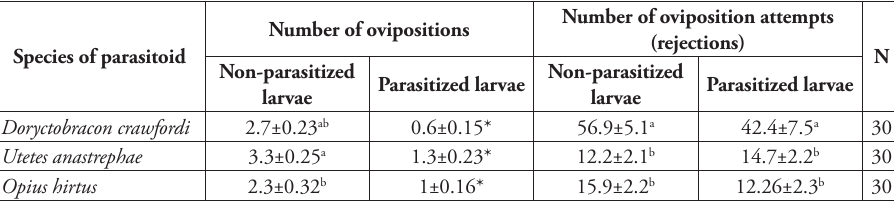
Different letters indicate statistically significant differences (Anova, α =0.05) between species of parasitoids. *Indicates a statistically significant difference between parasitized and non-parasitized hosts. Table 3. Average values (±SE) of duration of oviposition, vibration of the abdomen of the females, and im- mobility of the host after stinging (all in minutes) in non-parasitized and parasitized host larvae of A. ludens . Species